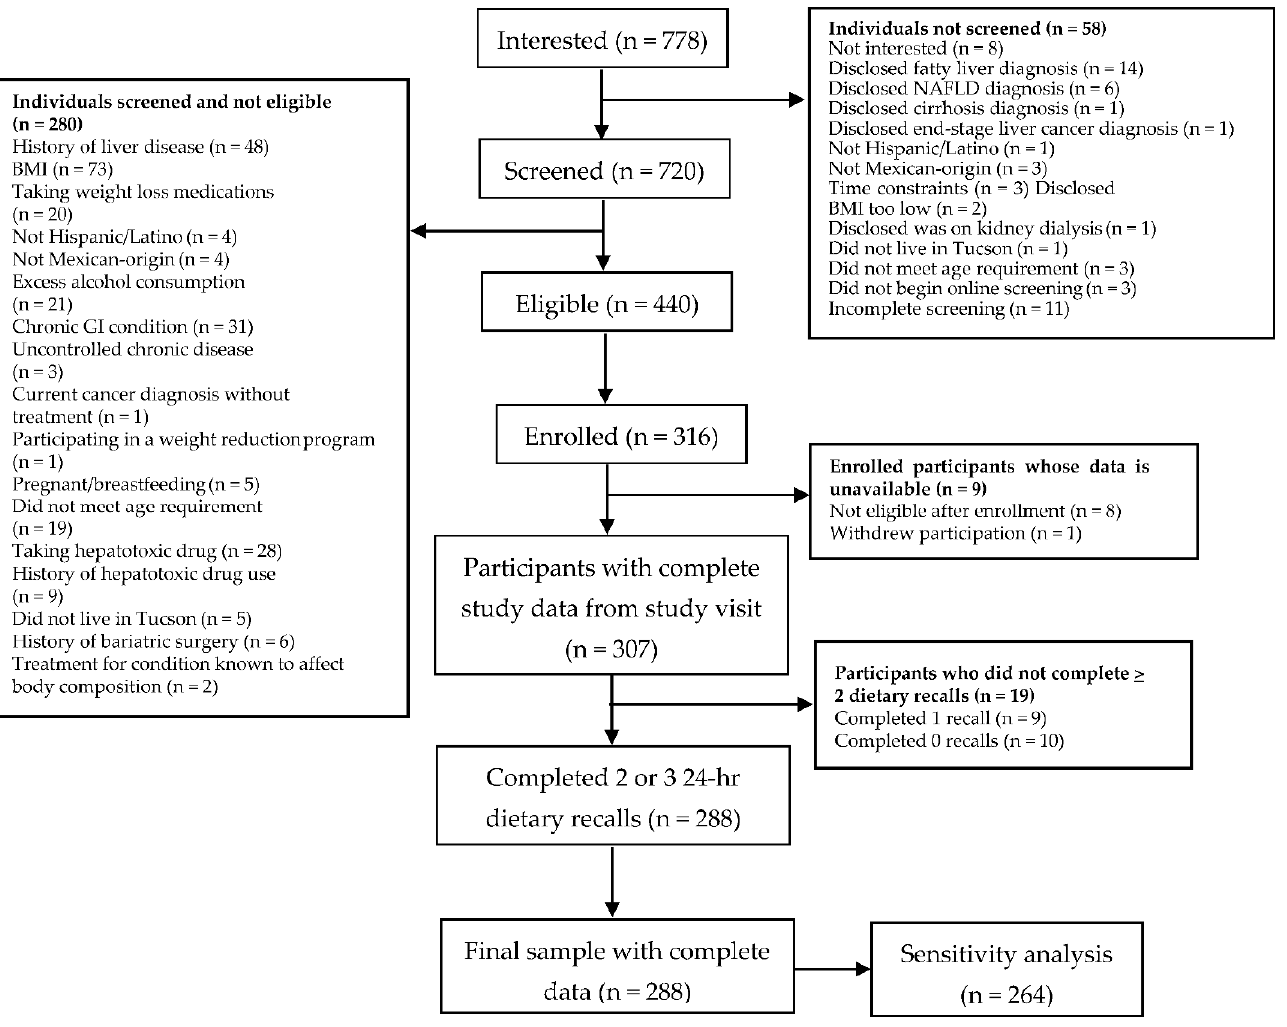
Figure 1. This is a figure. Schemes follow the same formatting. Figure 1. Cross-Sectional Study Participant Flow